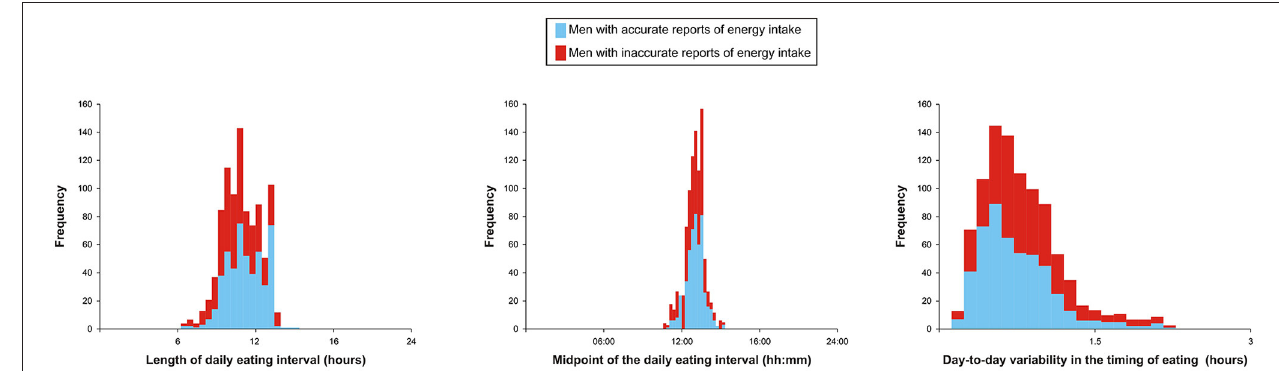
FIGURE 1 | Histograms for meal timing variables split by reliability of the dietary